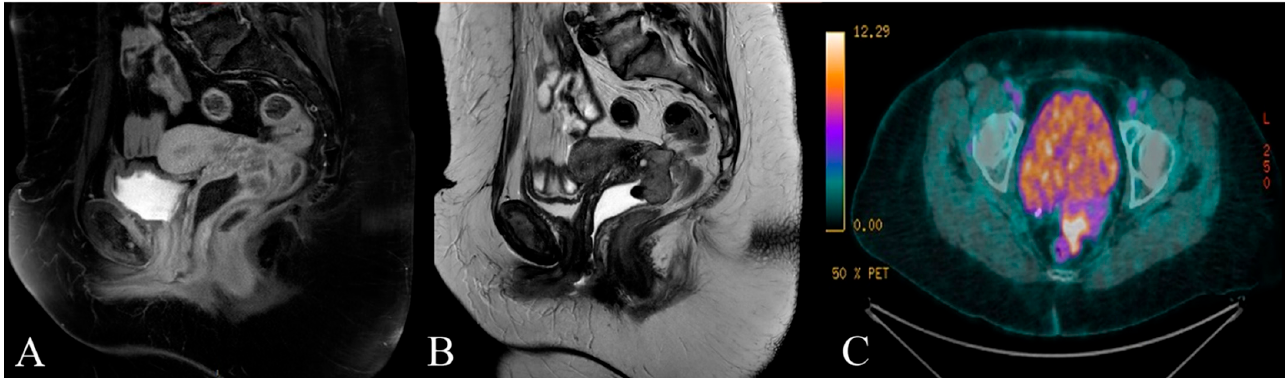
Figure 1. ( A ) T1 and ( B ) T2 weighted sagittal magnetic resonance (MR) image of the patient showing the solid mass of the posterior vaginal fornix infiltrating the Douglas pouch and possibly the rectal wall; ( C ) transversal image from positron emission tomography–computed tomography (PET-CT) showing the abnormal fluorine-18-deoxyglucose accumulation in the mass.